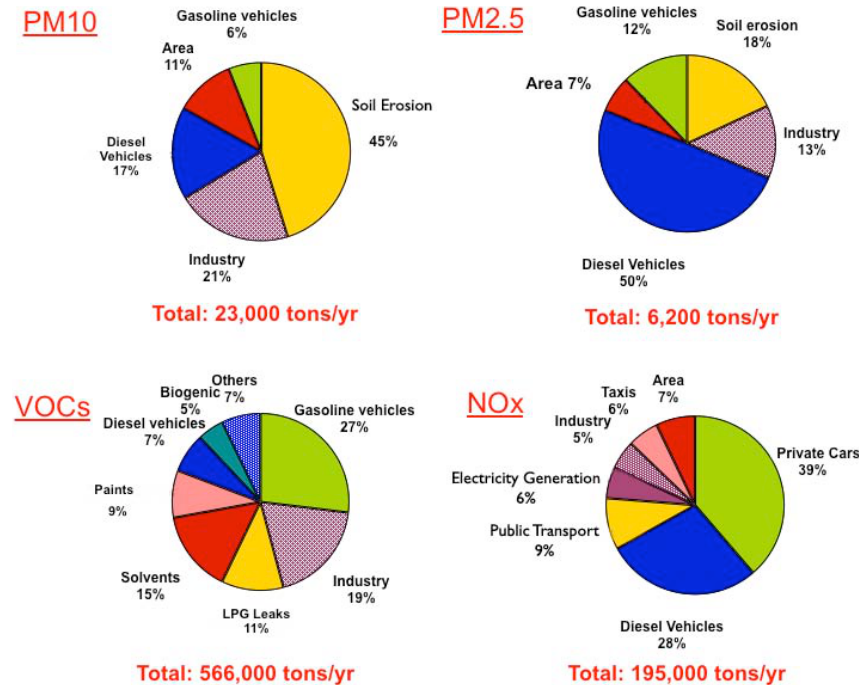
Fig. 6. Emissions Inventory of the MCMA for the year 2006 (Source: